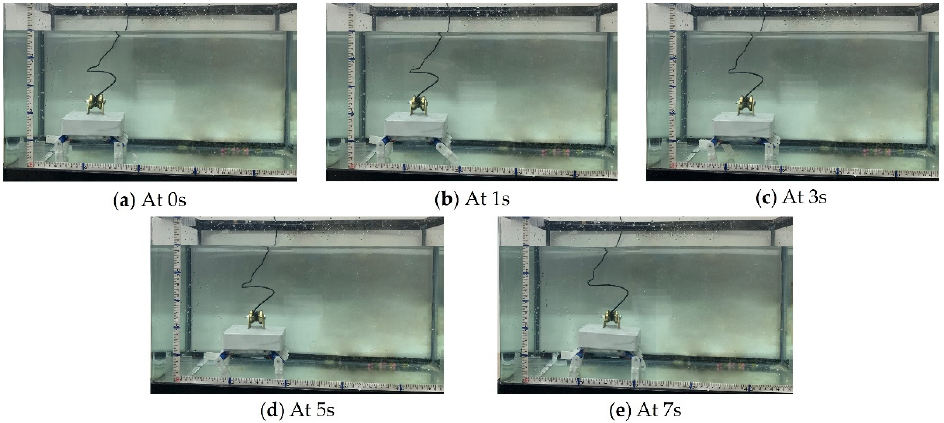
Figure 18. Experiments on walking motion in one walk cycle.